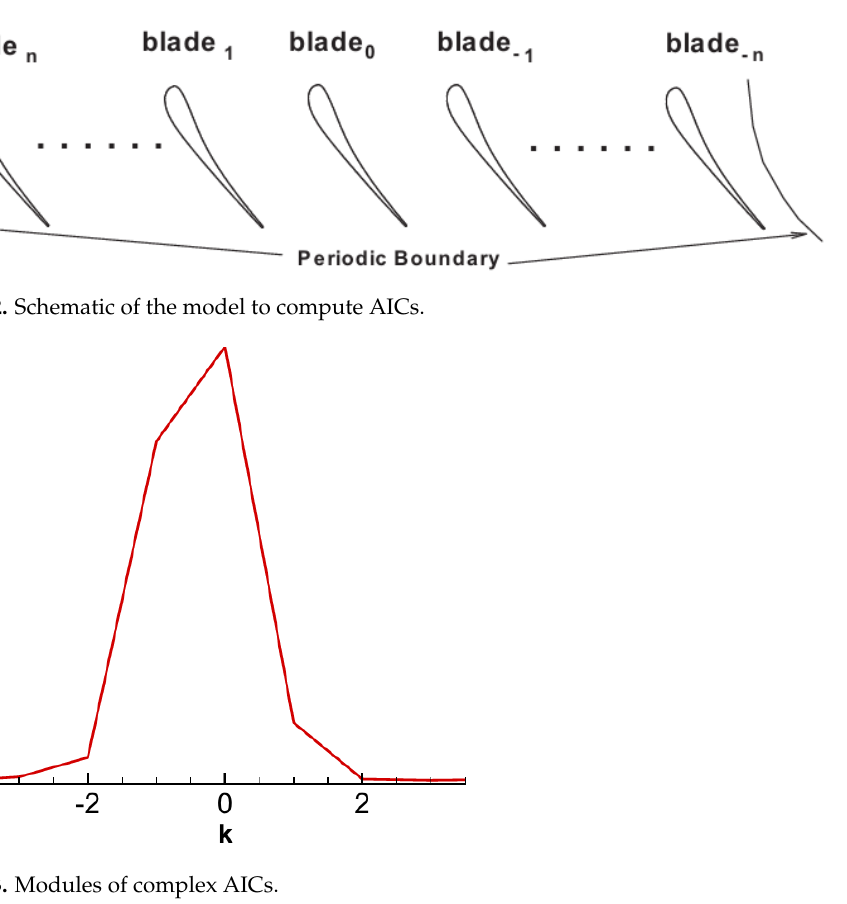
Figure 13. Modules of complex